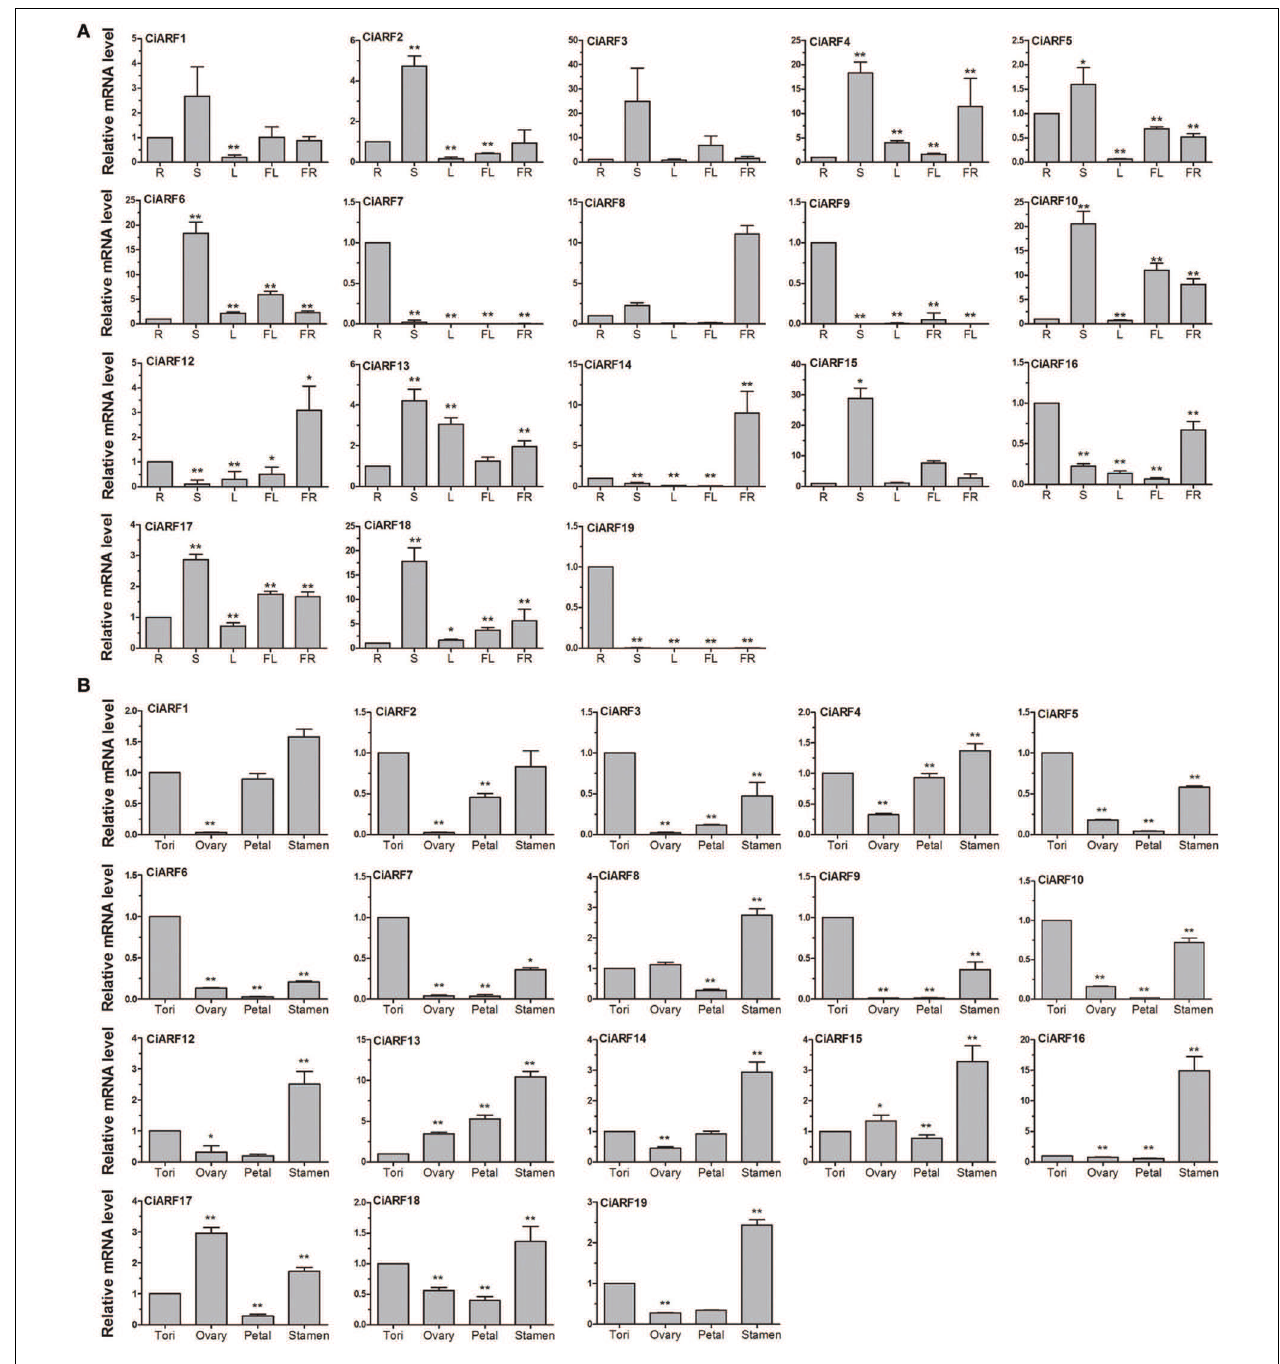
in floral organs of sweet orange, torus (T), ovary (O), petal (P), and stamen (S). Relative transcript levels are calculated by real-time PCR with β - actin as a standard. Data are means ± SE of three separate